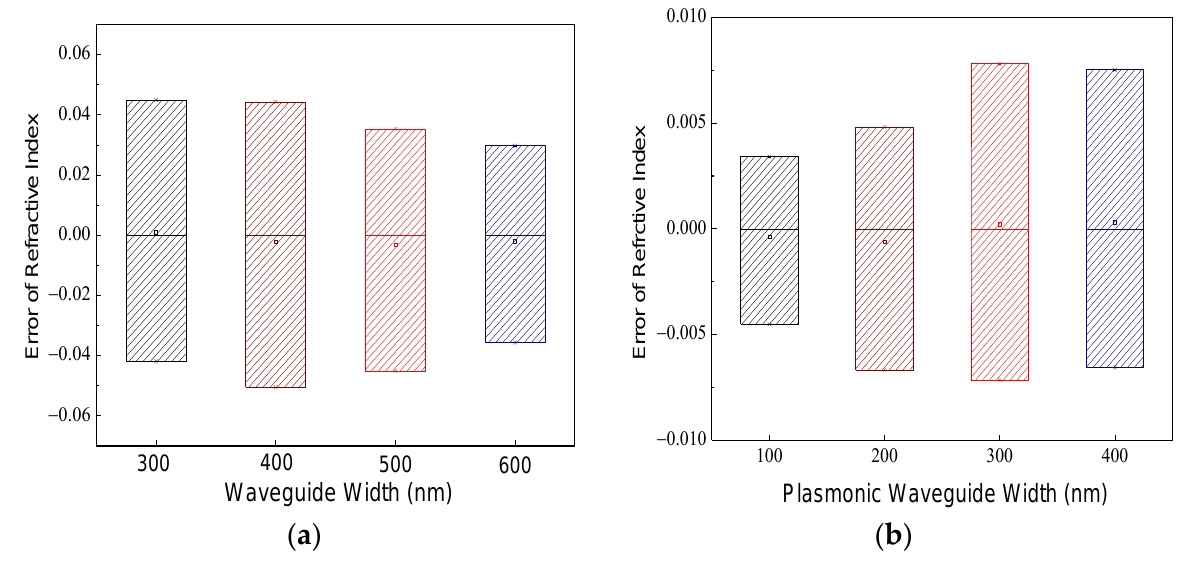
Figure 7. ( a ) The error of refractive index for different silicon waveguide widths; ( b ) the error of refractive index for different plasmonic waveguide widths.